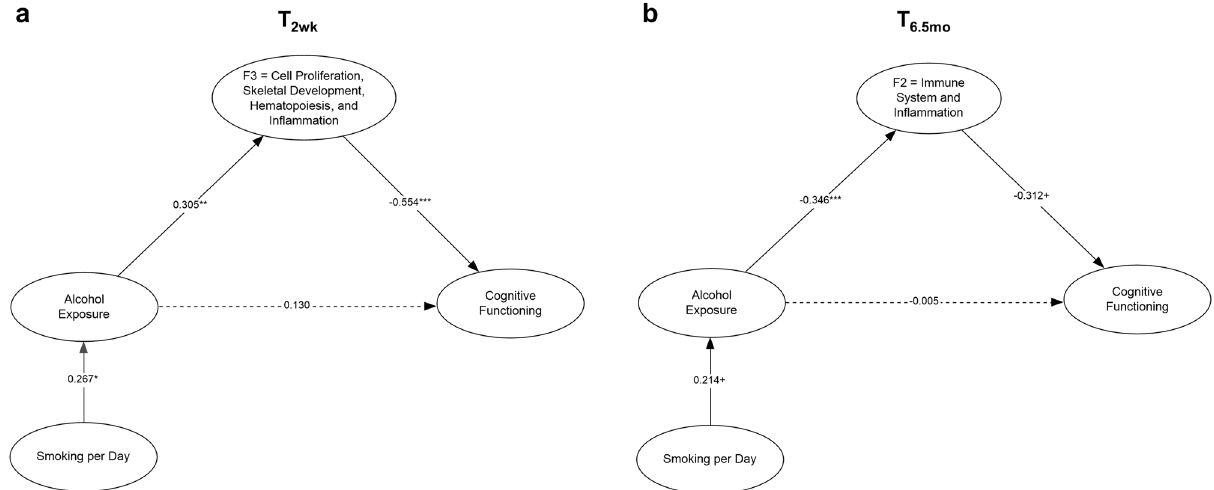
Figure 7. Mediational model predicting cognitive function. Cognitive function (measured by FTII visual recognition memory at 6.5 months) mediation from the direct effect of alcohol exposure and the indirect effect of alcohol exposure mediated by the ex miRNA factors at ( a ) T 2wk and ( b ) T 6.5mo and adjusted for maternal smoking during pregnancy. Model included all three miRNA factors with residual correlations between them 139 . For T 2wk , figure displays only F3, for which significant mediation was found. The indirect effect of alcohol exposure on cognitive functioning through F3 was significant ( b = − 0.169, p = 0.032). The factors for which significant mediation was not evident (F1 and F2) are omitted from the figure for clarity. For T 6.5mo , figure displays only F2, for which the mediational effect fell short of conventional levels of statistical significance ( b = 0.108, p = 0.109), but using a one-tailed test mediation is evident. The factors for which significant mediation was not evident (F1 and F3) are omitted from the figure for clarity. † p < 0.10; * p < 0.05; ** p < 0.01; *** p < 0.001. ). Figures were constructed using Inspiration (version